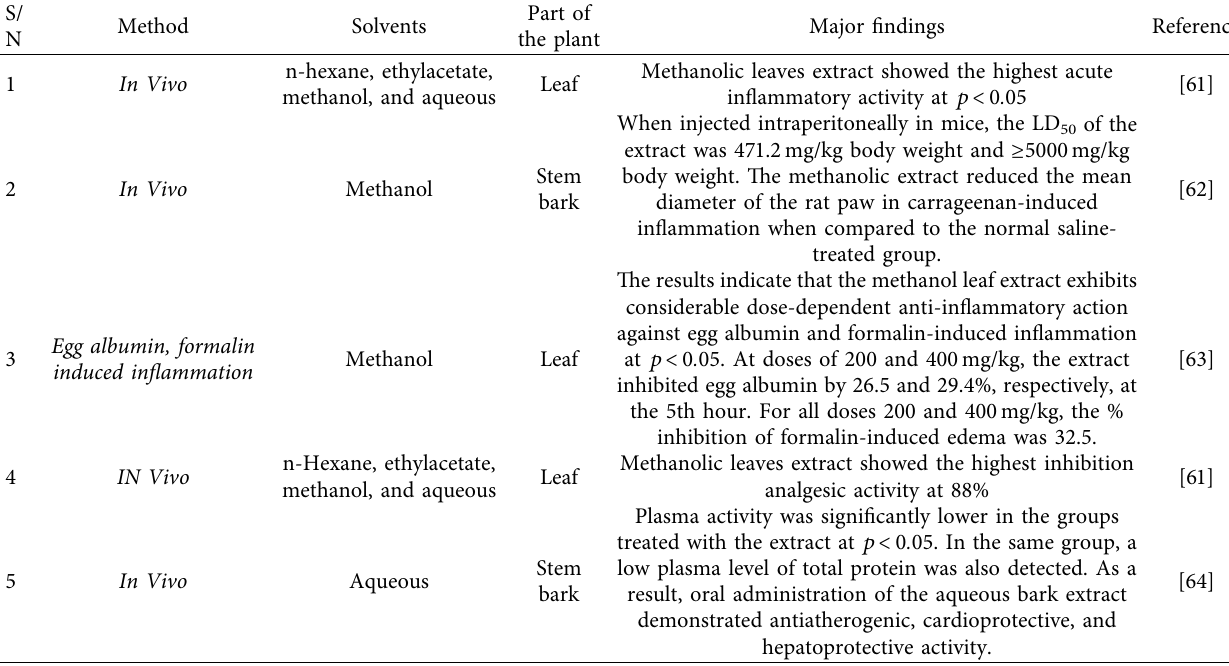
Table 3: Anti-inflammatory activity of D. microcarpum